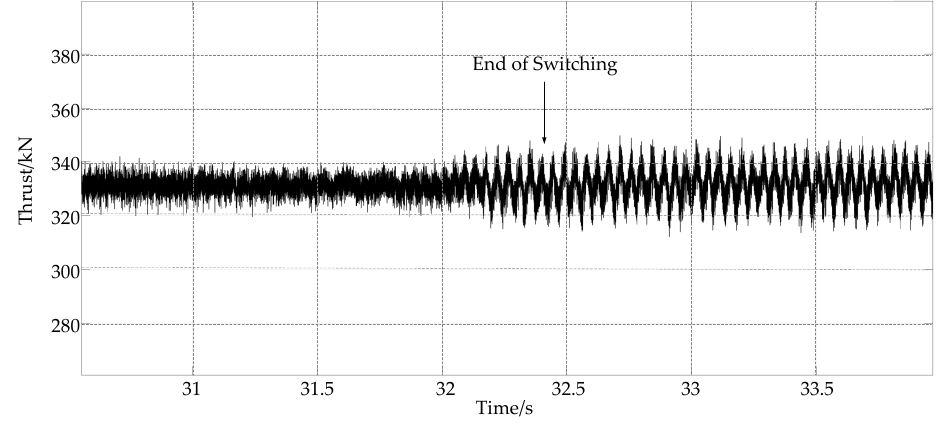
Figure 22. Train thrust during switching.